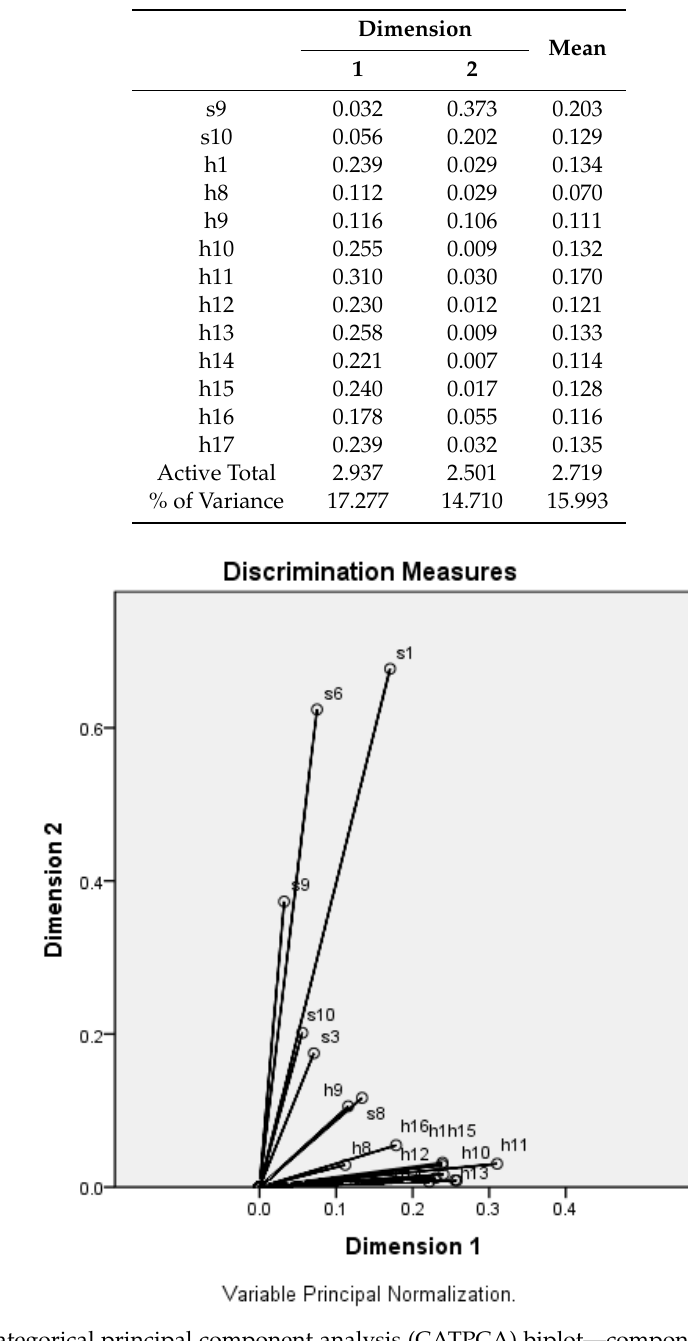
Figure 1. Categorical principal component analysis (CATPCA) biplot—component loadings of the most explanatory variables. Note: items—s1, s3, s6, s8, s9, s10, h1, h8, h9, h10, h11, h12, h13, h14, h15, h16, h17.